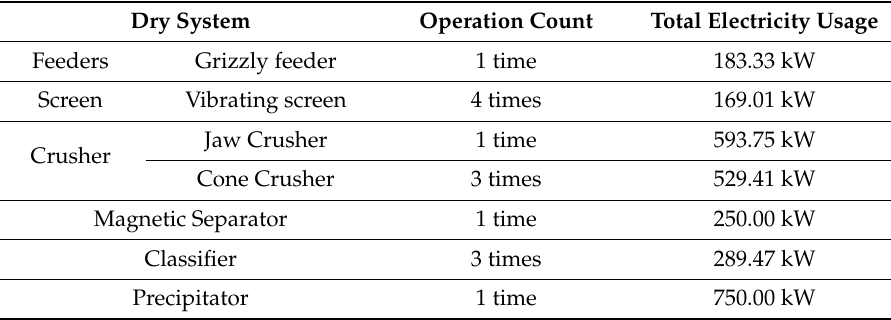
Table 2. Manufacturing facility of dry recycled aggregate.